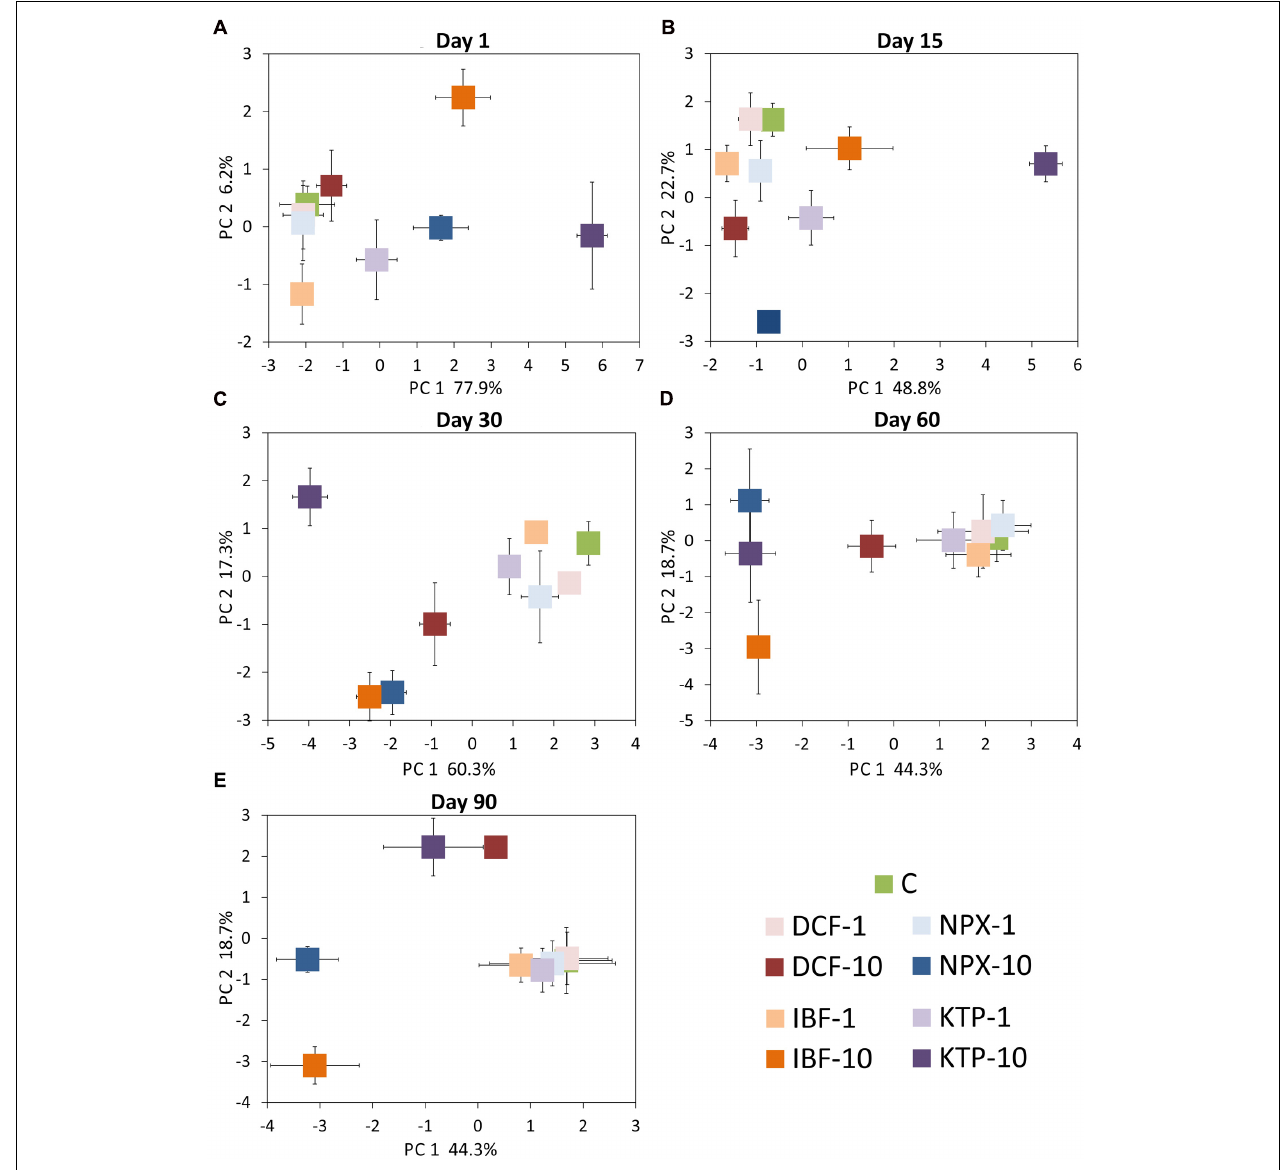
FIGURE 11 | Principal component plots generated from the measured parameters on days 1 (A) , 15 (B) , 30 (C) , 60 (D), and 90 (E) . C, control soil; DCF-1, soil treated with diclofenac – 1 mg/kg soil; DCF-10, soil treated with diclofenac – 10 mg/kg soil; NPX-1, soil treated with naproxen – 1 mg/kg soil; NPX-10, soil treated with naproxen – 10 mg/kg soil; IBF-1, soil treated with ibuprofen – 1 mg/kg soil; IBF-10, soil treated with ibuprofen – 10 mg/kg soil; KTP-1, soil treated with ketoprofen – 1 mg/kg soil and KTP-10, soil treated with ketoprofen – 10 mg/kg